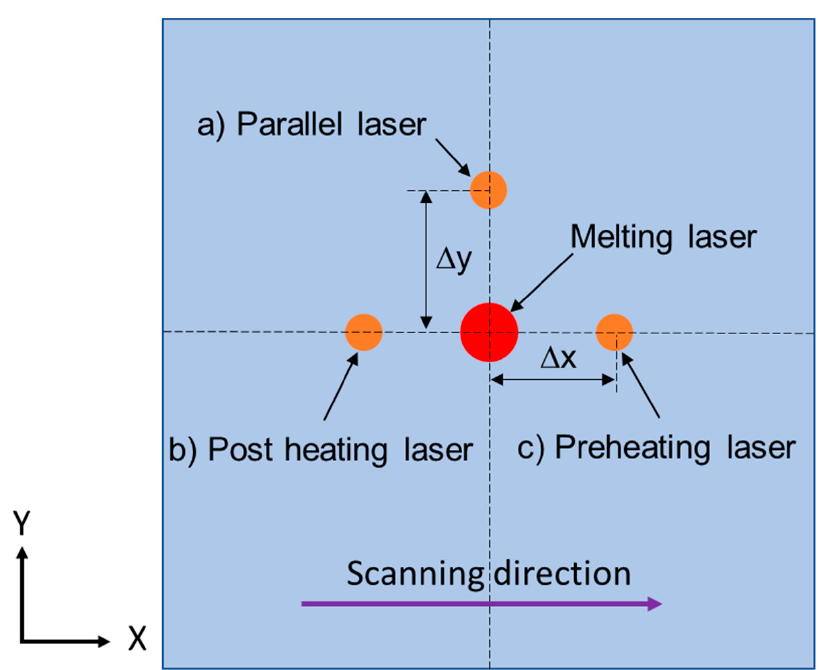
Figure 1. Model configurations.